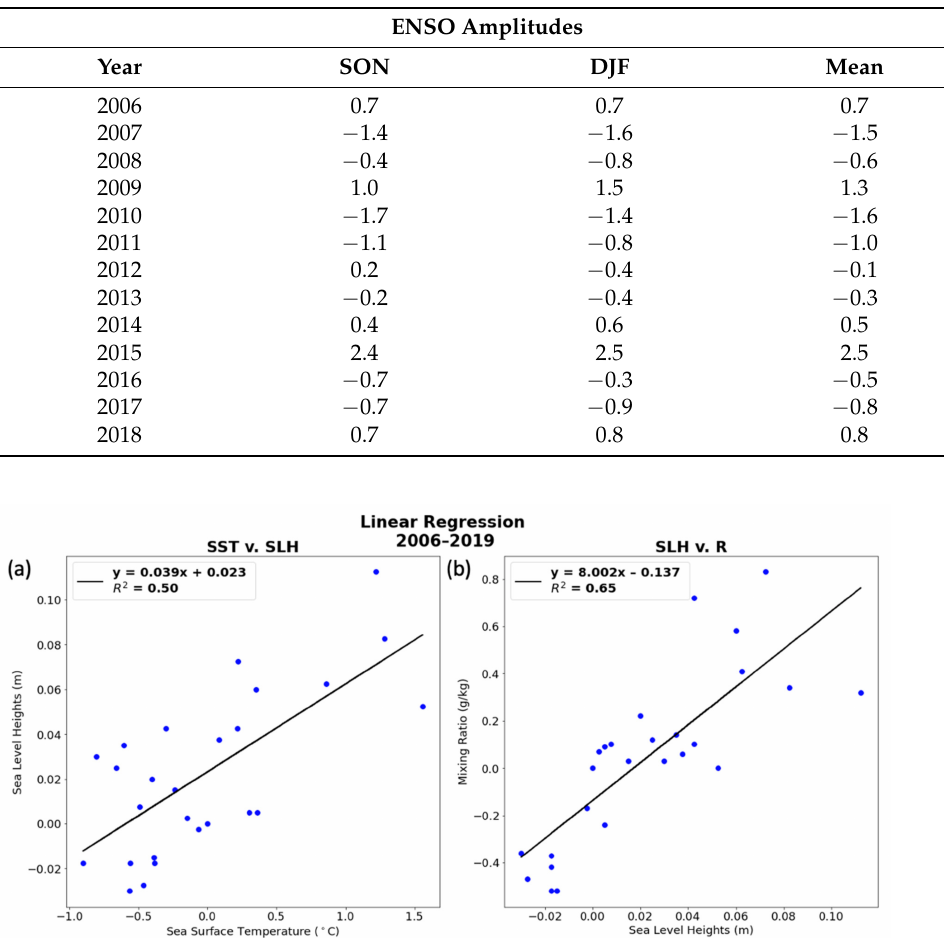
Table 5. ENSO amplitudes from 2006 through 2018 to show the comparison with seasonal sea surface temperatures.